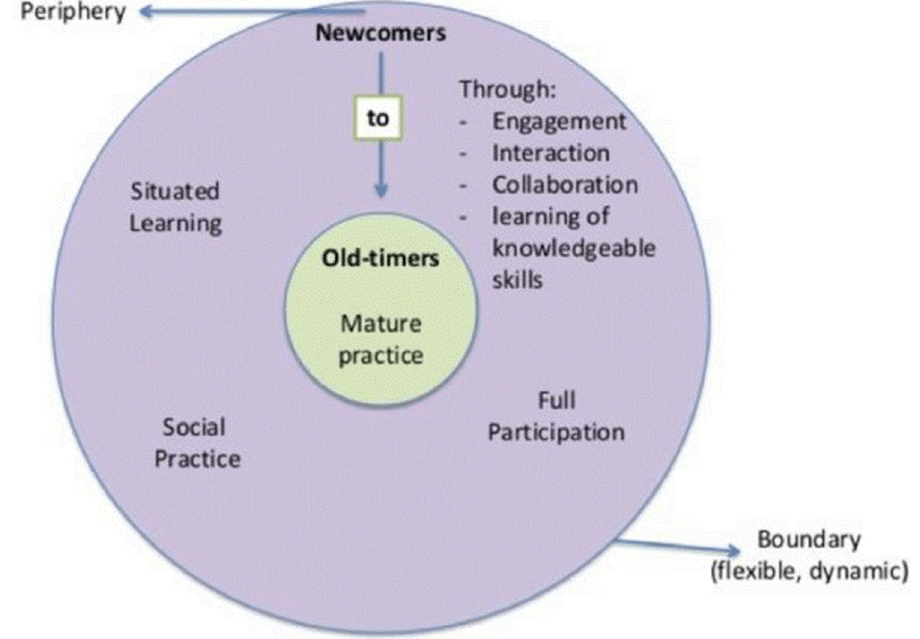
Fig 2. The flow of the CoP. The entry of newcomers in the communities of practice (CoPs), learning by engagement and interaction. The newcomers continue their path into the centre of the CoP, becoming old-timers at the practice (modified from